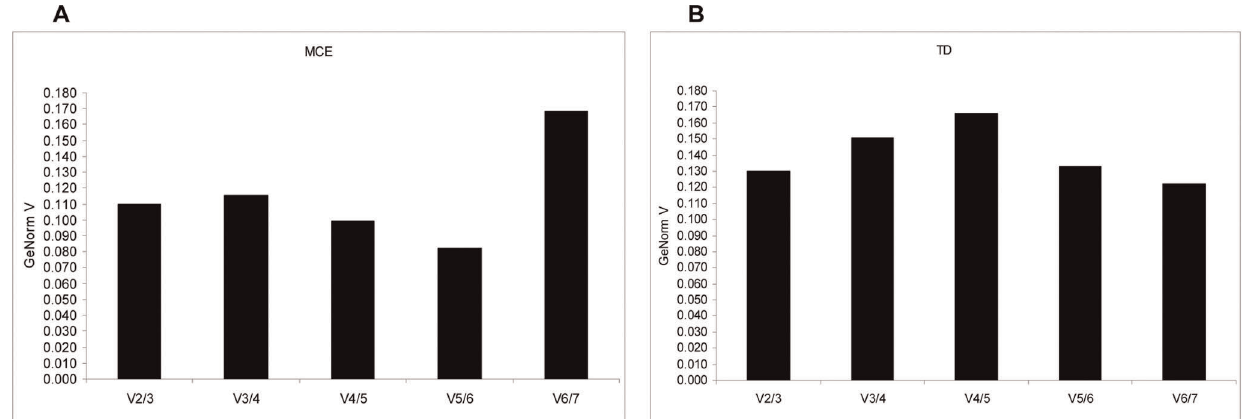
Figure 3. Determination of optimal number of RGs for qPCR data normalization by geNorm. Determination of the optimal number of RG for the normalization of qPCR data analysis was performed using the geNorm algorithm. The V parameter is used to determine the optimal number of RGs required normalizing the expression of candidate genes. the V cut-off value was set to 0.15, below which the inclusion of an additional RG is no longer required. V2/3 is based on the geometric mean of the normalization factors of ATP-5b, Nono and HPRT during MCE (A), and NoNo, RPL and ACTB during TD (B) of 3T3-L1 cells.